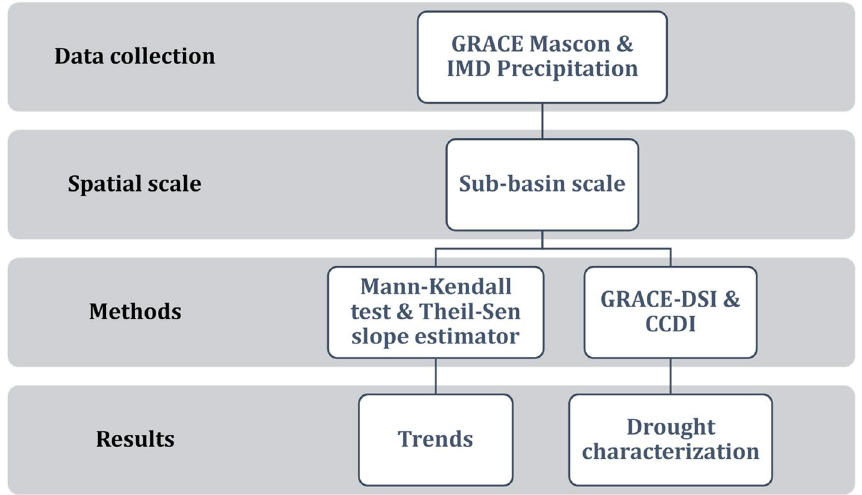
Figure 2. Flow chart of the proposed study discussed above with the spatial scale involved and the methods to evaluate the trend and drought